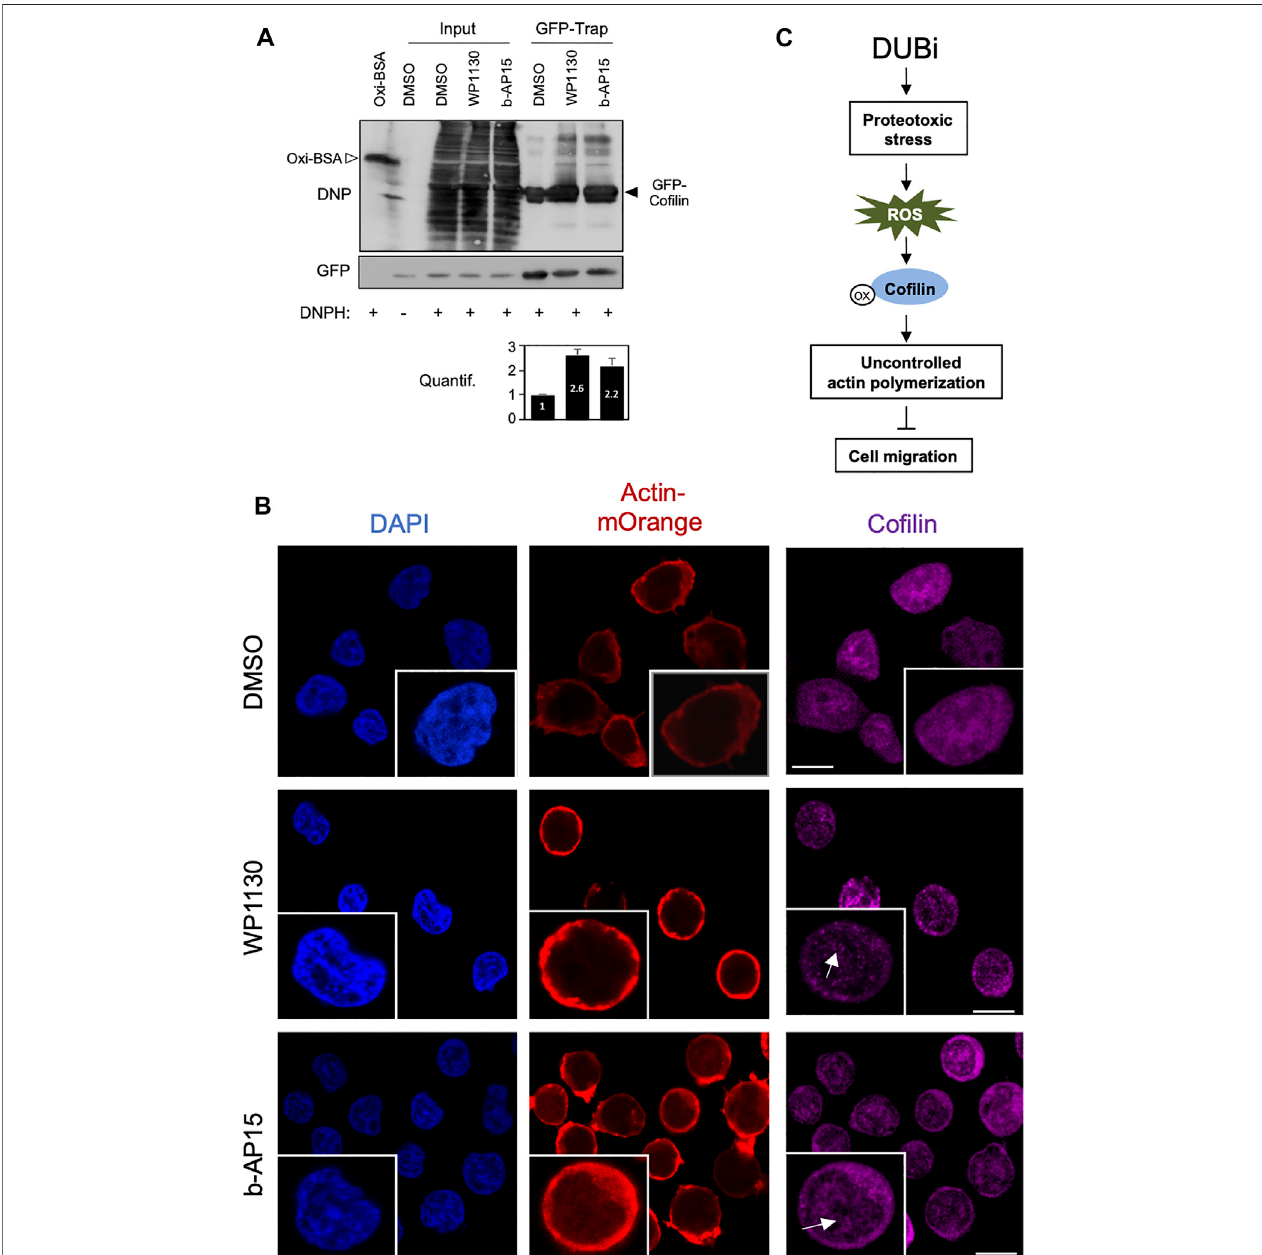
FIGURE6| Inhibition ofDUBs inleukemiccells inducesCo fi linoxidation and oligomerization. (A) Jurkatcells stablyexpressing GFP-co fi linweretreatedor notwith 15 µMWP1130orb-AP15for30 minandlysed.Celllysateswereincubatedwithanti-GFPnanobody(GFP-Trap)coupledtoagarosebeads.Thetrappedproteinsanda fraction of the cell lysates (Input) were incubated with DNPH for 15 min at room temperature before immunoblot with antibodies against DNP or GFP. Anti-DNP immunoblot of DNP-labelled oxidized BSA (40 ng) is shown as a control. Data are representative of n (cid:2) 2 experiments. Densitometric quanti fi cation of co fi lin oxidationagainstGFPsignalisshownasbargraph(bottompanel). (B) Immuno fl uorescencemicroscopyanalysisofactin-mOrangeandCo fi lindistributioninACTJurkat celltreatedwithDMSOor15 µMofWP1130andb-AP15for30 min.Scalebar,10 µm.Inset,whitearrowsshowCo fi linaggregates. (C) Schematicoverviewoftheeffect of DUB inhibition on co fi lin activity, actin polymerization and cell